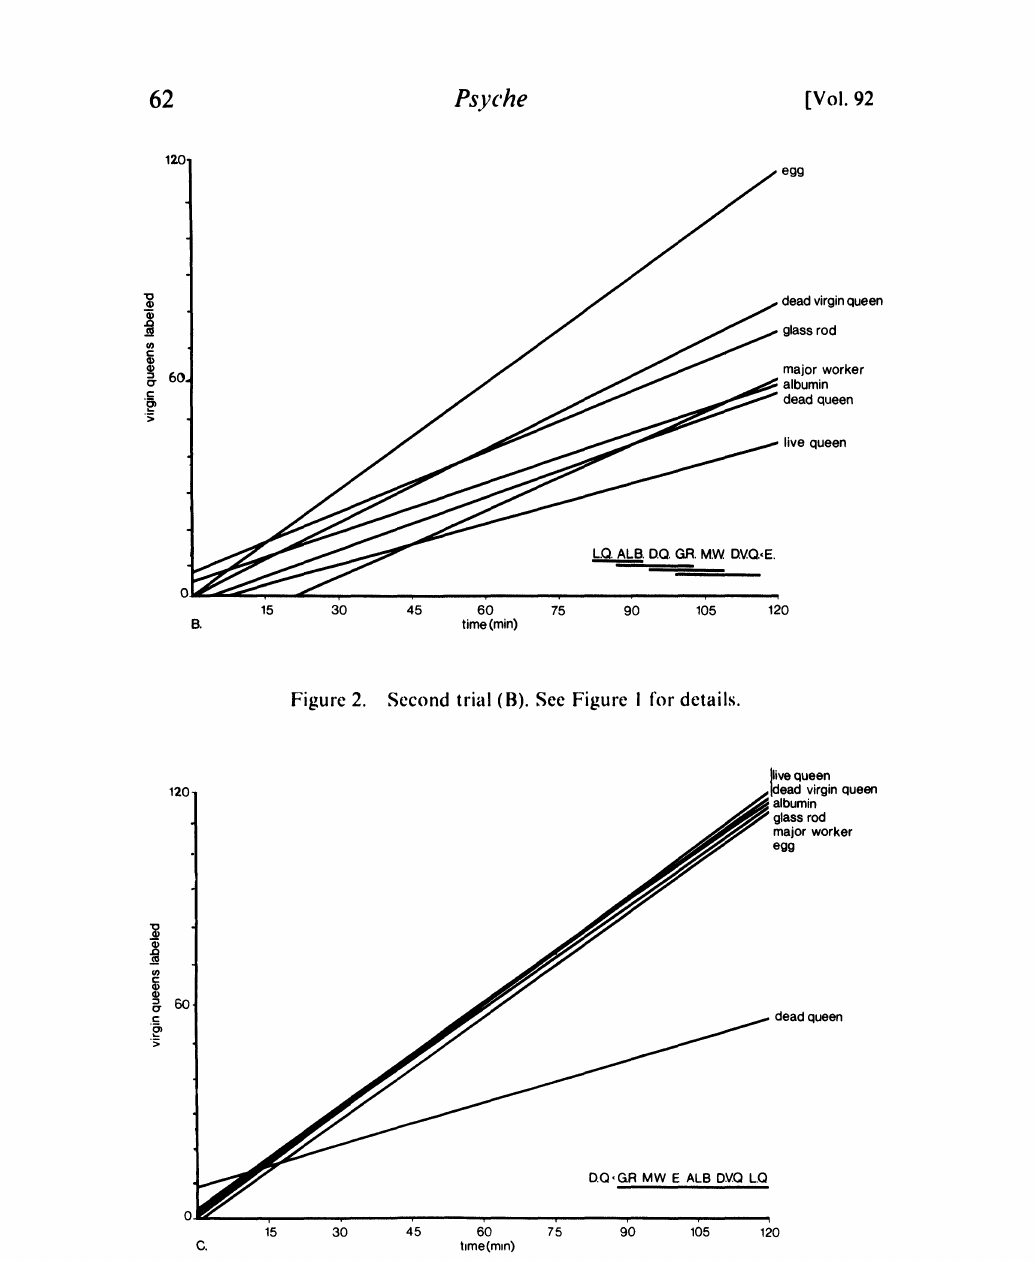
Figure 3. Third trial (C). See Figure for